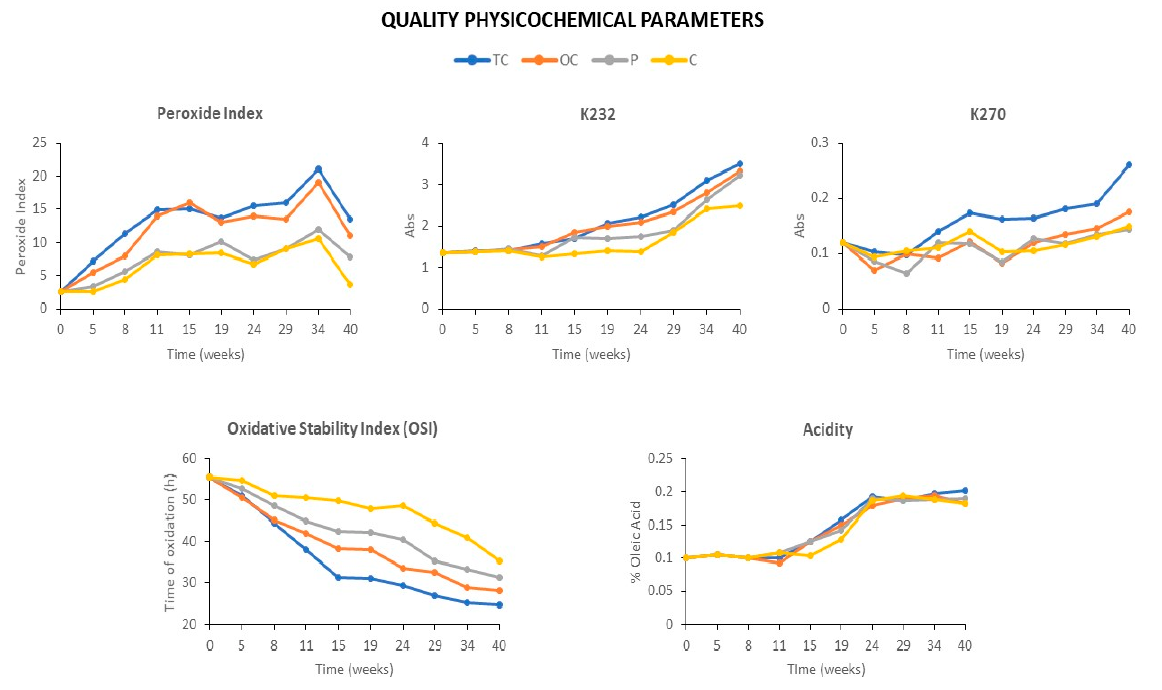
Figure 1. Evolution of quality parameters of olive oil with the storage time in different containers.